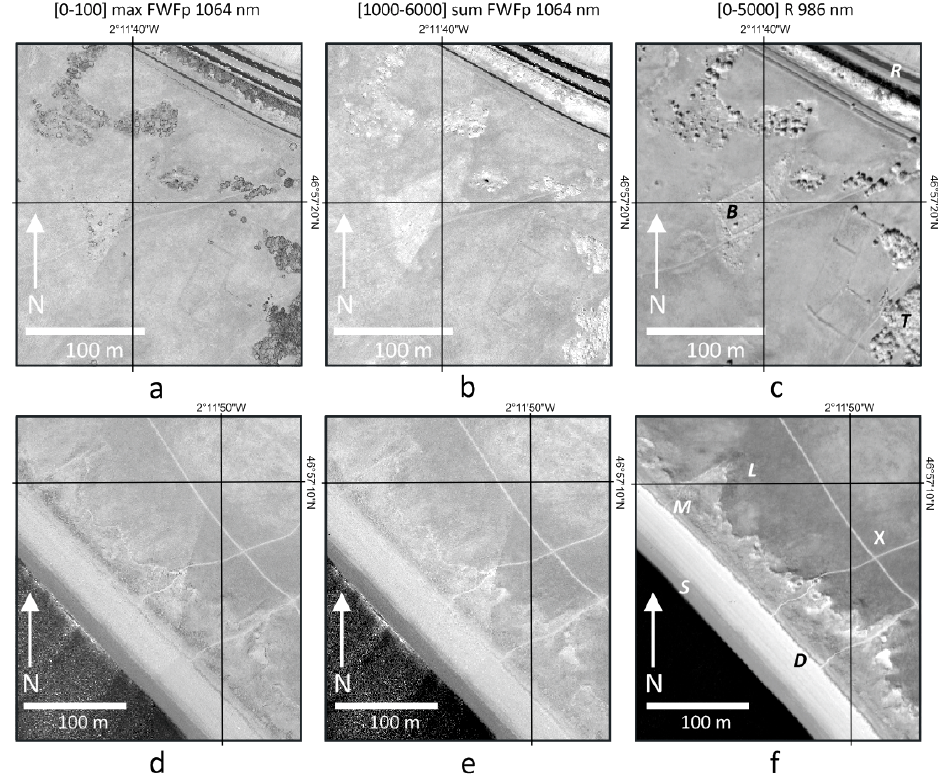
Figure 4. Area of interest (AOIs) 1 and 2 located in Figure 1c, showing respectively in ( a , d ) the maximum intensity of the FWFp, ( b , e ) the sum of the FWFp, and ( c , f ) the hyperspectral reflectance at 986 nm. Creation of grey scale displays are indicated in brackets. 986 nm. Creation of grey scale displays are indicated in